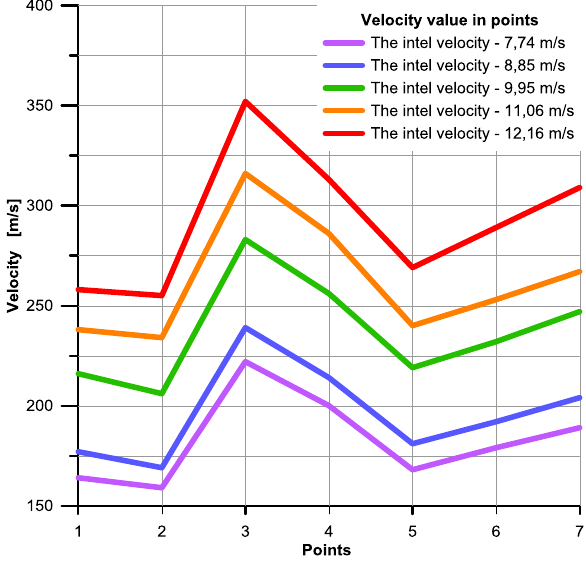
Fig. 8. The results of velocity in the tunnel for measurement points .